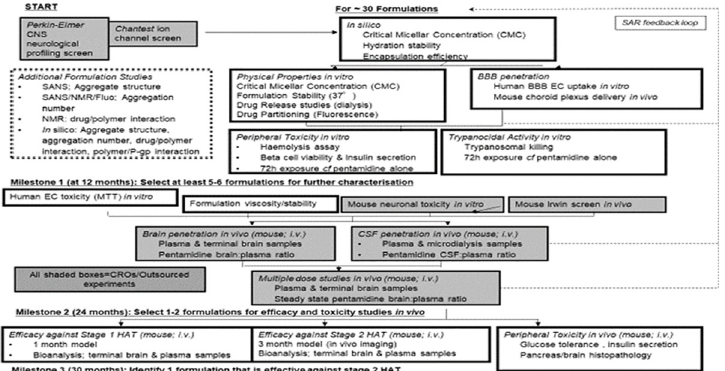
Fig 1. NANOHAT project screening cascade. We used a structure activity relationship (SAR) feedback loop to further refine the selection of the lead formulations progressing through the screening cascade We screened approximately 30 pentamidine/Pluronic formulations during this project using this rational, iterative approach. The three milestones were intended to ensure that the most appropriate formulations, on the basis of in silico and in vitro data, were taken forward to the in vivo pharmacokinetic studies and that the formulations with the greatest likelihood of success would be tested in the whole animal efficacy studies as outlined in the progression